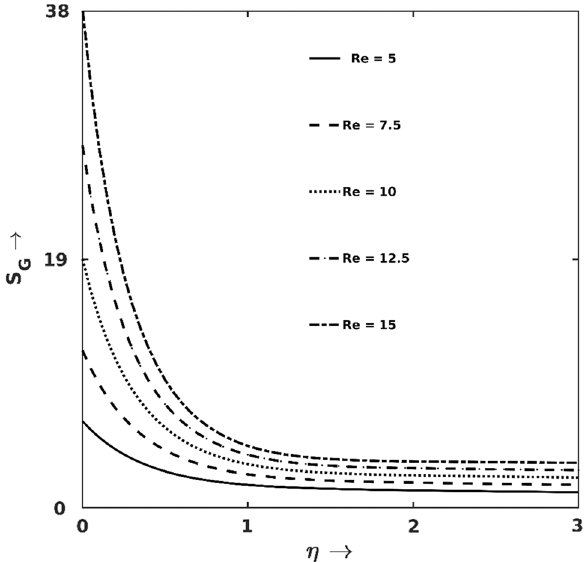
(cid:30) graph for different R 1 . √ Re